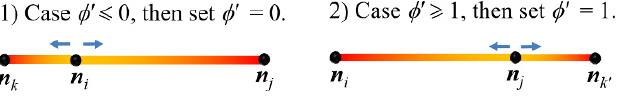
Division point propagation for nodes with valence two. Arrows indicate the agent movement direction. Case 1: if the new division ratio φ 0 (cid:54) 0, then it is possible that the agents move faster along edge { i,j } than agents along edge { k,i } . Case 2: if φ 0 (cid:62) 1, then the agents may move faster along edge { i,j } than agents along edge { j,k 0 } . In either case, the division point should be propagated from { i,j } to { k,i } or { j,k 0 } , respectively.